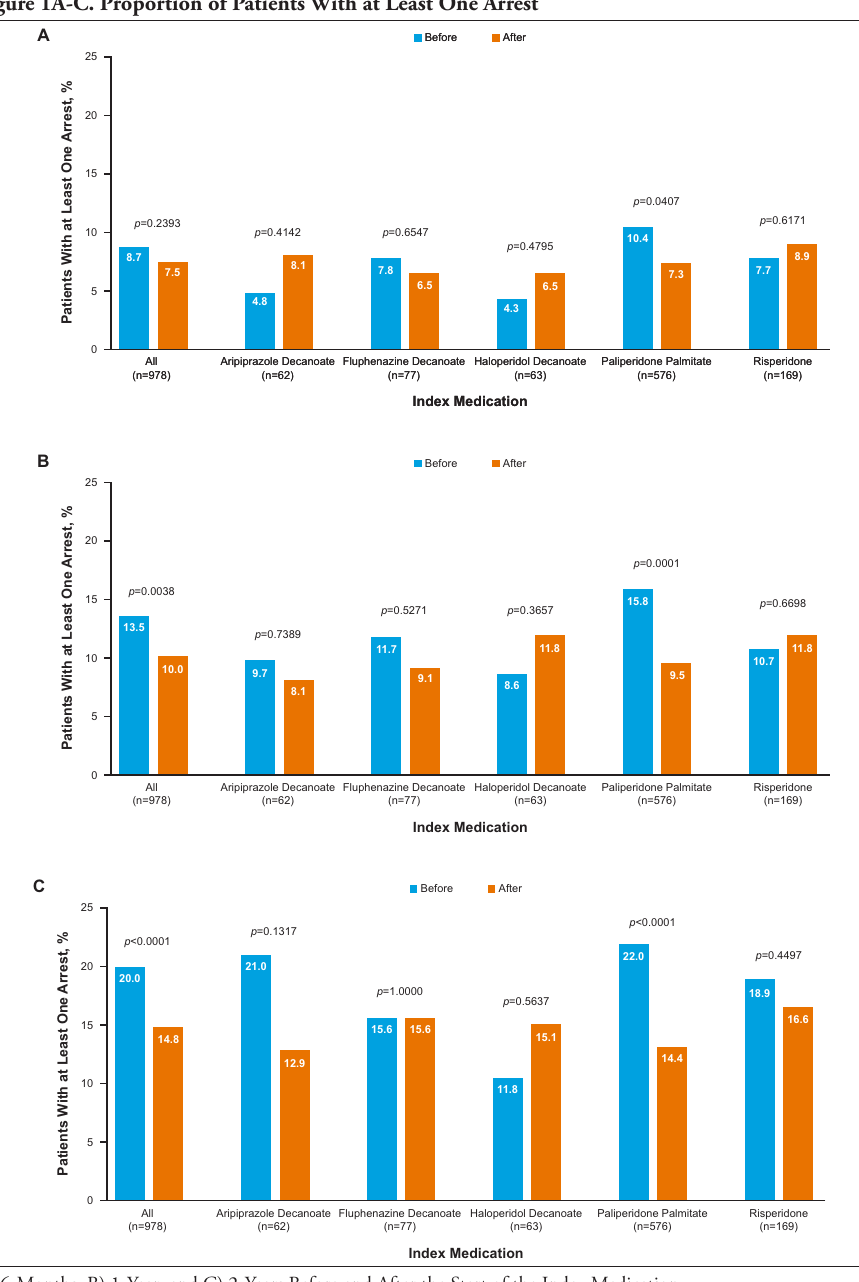
Figure 1A-C. Proportion of Patients With at Least One